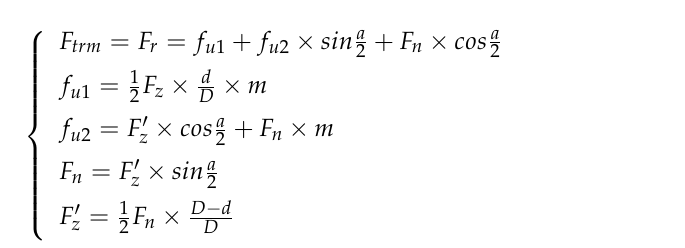
Table 2. Parameters level of the TRM structure.